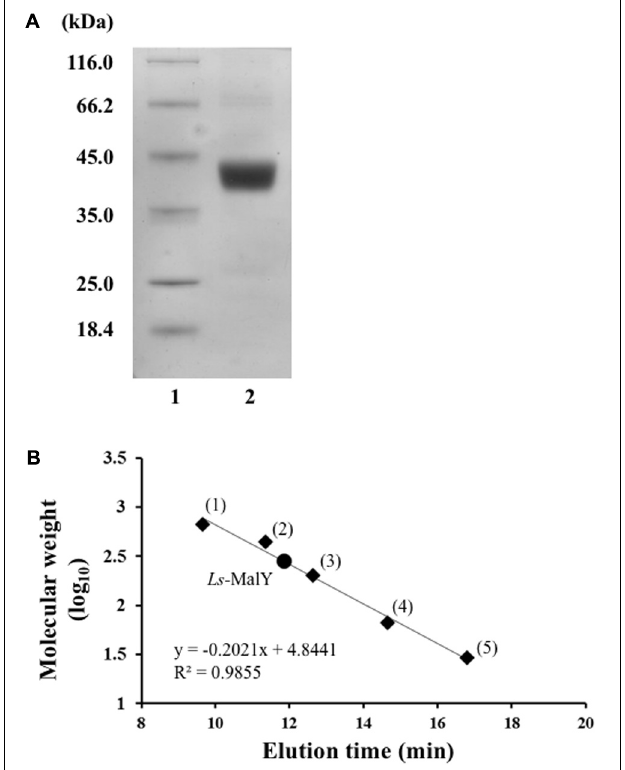
FIGURE 2 | SDS-PAGE (A) and gel filtration chromatographic (B) analyses of WT Ls -MalY. (A) Lanes 1 and 2 indicate molecular weight marker and purified Ls -MalY (4 µ g), respectively. (B) Thyroglobulin (1: 669,000 Da), apoferritin (2: 443,000 Da), β -amylase (3: 200,000 Da), BSA (4: 66,000 Da), and carbonic anhydrase (5: 23,000 Da) were used as molecular weight